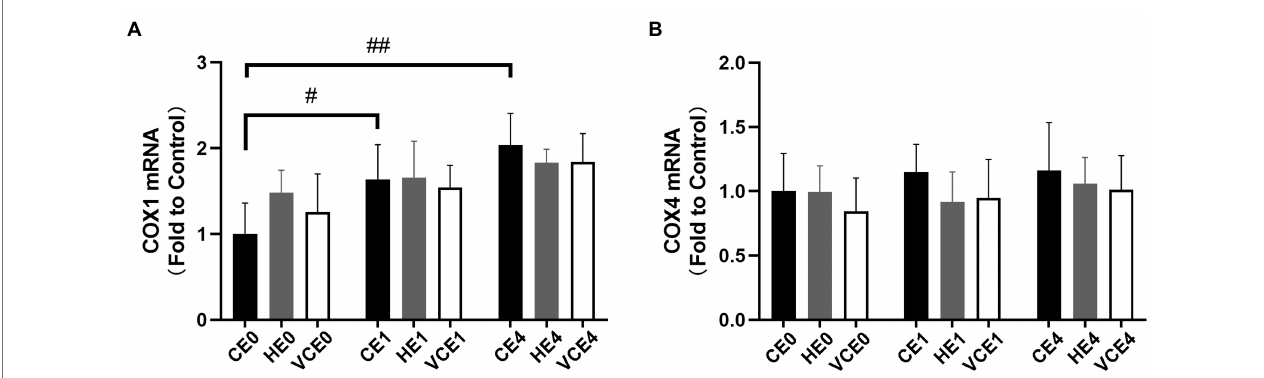
FIGURE 2 | Average mRNA expression levels of COX1 (A) and COX4 (B) subunits. C, blank control; H, inhalation of hydrogen gas; VC, vitamin C supplementation; E0, baseline; E1, immediately after exercise; and E4, 4 h after exercise. n = 8 per group. # p < 0.05; ## p < 0.01.